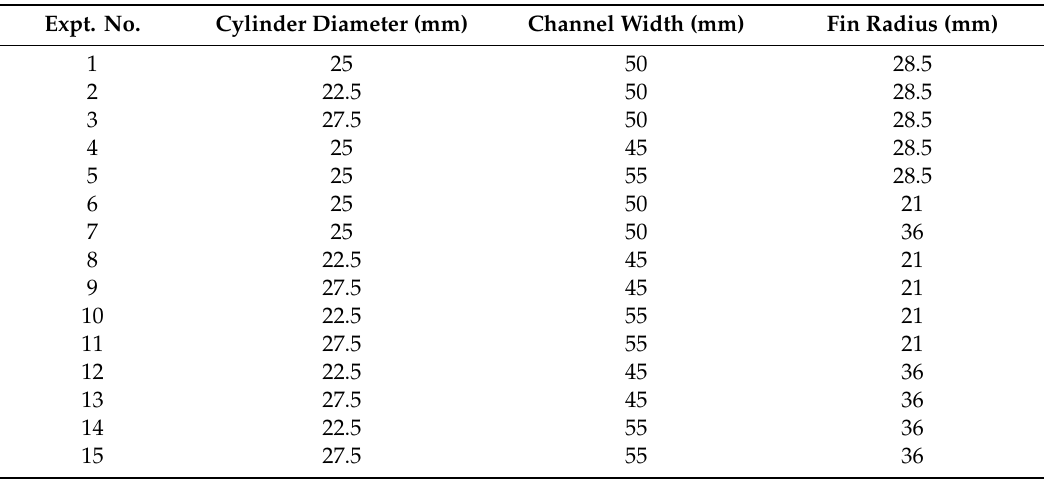
Table 4. Experimental layout.